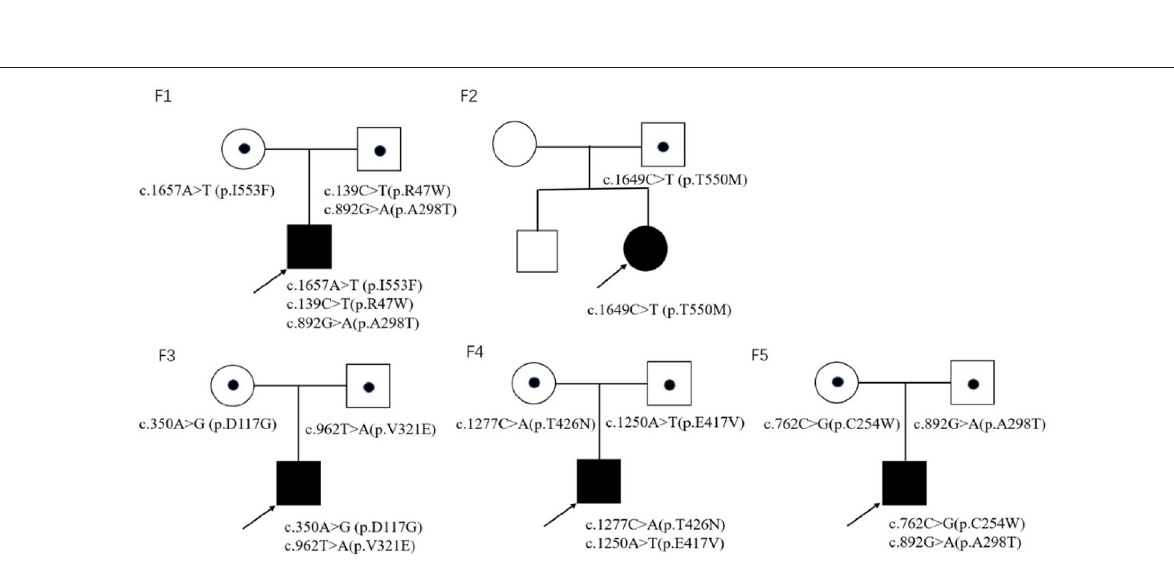
FIGURE 2 | The pedigrees of five families in this